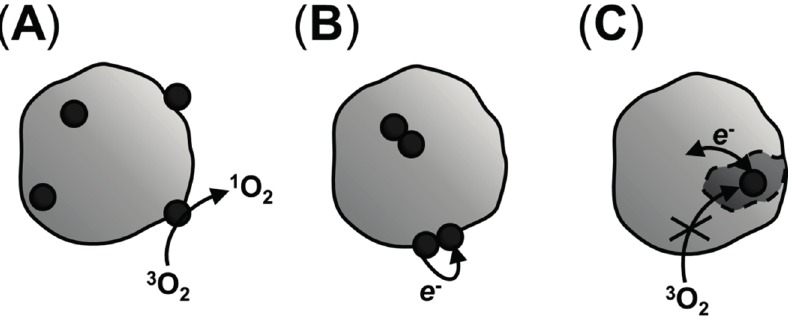
Figure 3. Possible outcomes of the interaction between photosensitizers (PSes) and binding sites of macromolecules or particles, considering triplet excited states deactivation pathways: ( A ) stabilization of the monomeric form of the PS and formation of singlet oxygen by energy transfer; ( B ) stabilization of the dimeric species, favoring the dye–dye mechanism; and ( C ) binding of the PS to a pocket inaccessible to oxygen, raising the probability of electron transfer